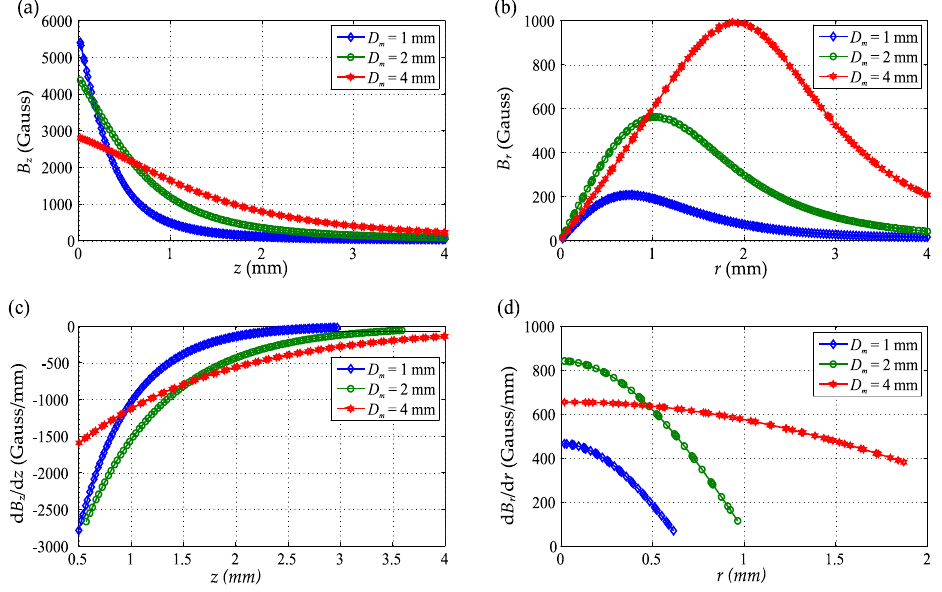
Figure 4. The magnetic field comparison of different sizes of magnets ( H m = 1 mm, D m = 1, 2, 4 mm): ( a ) B z with z at r = 0 mm; ( b ) B r with r at z = 1 mm; ( c ) B z gradient in z axis; ( d ) B r gradient in r axis.